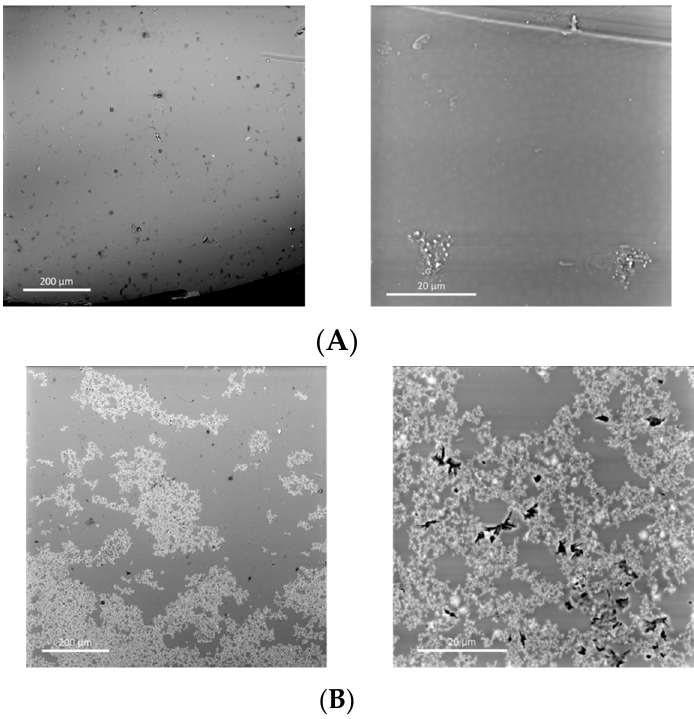
Figure 13. SEM micrographs of the membranes prepared from the polymer LMW-sPEES with ( A ) 6% MCF-NH 2 ; and ( B ) 6% MCF-SO 3 H.